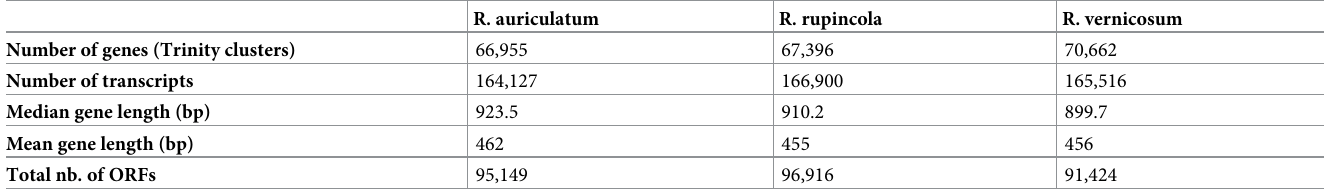
Table 1. Summary statistics of the three floral